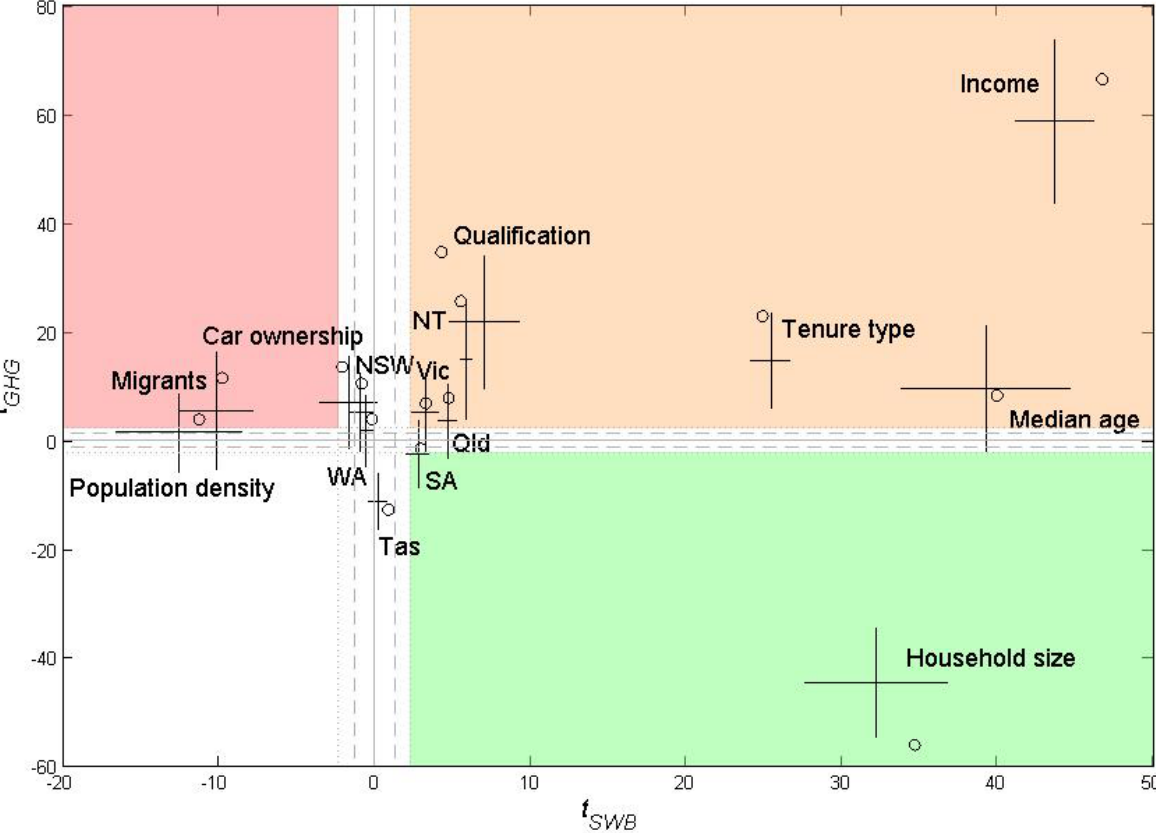
Figure 3. Student’s t statistics for Equations 1d and 3d (o symbols), as well as means and standard deviations (cross-bars) across all regressions. Green: “Win-win” area, orange: “trade-off” area, red: “lose-lose” area. White lines are drawn to delineate areas with t values indicating insufficient significance of regression